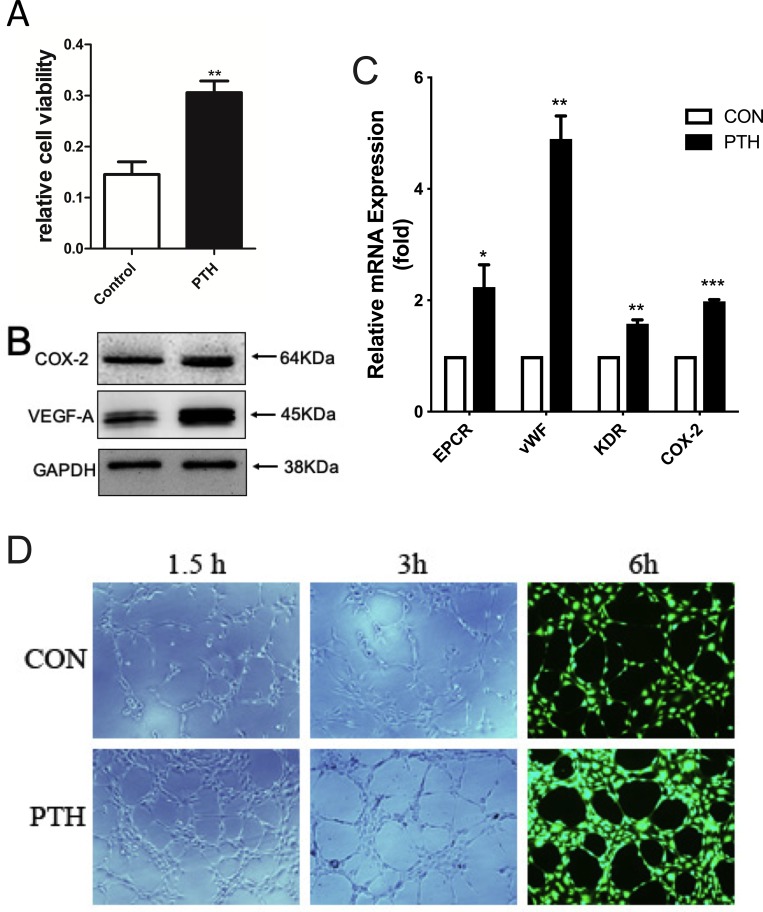
PTH enhances the proliferation and physiological function of endothelial cells in vitro.(A) HUVECs were treated with PTH or saline for 48 h (PTH treated 1 h every 24 h), and a CCK-8 assay was performed to determine the endothelial cell proliferative activity. (B) Western blot analysis for the expression of the VEGF and COX-2 protein levels. (C) qPCR for mRNA level analysis related to the function of endothelial cells after PTH treatment compared to that of the control. (D) The formation of tube-like networks was examined at 1.5 h, 3 h and 6 h by a tube formation assay. Representative micrographs obtained at 10× (D, scale bar, 50 μm). Student’s t test for two groups comparisons was performed; **P < 0.01, and ***P < 0.001.